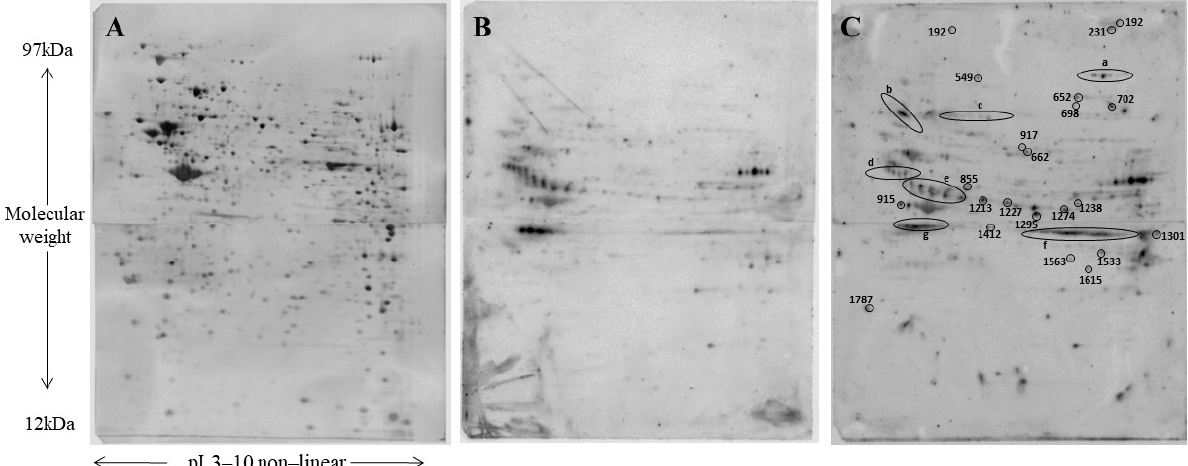
Figure 1. 2-DE coupled with WB was employed to detect specific phosphorylated proteins. Proteins from C2C12 cells were firstly separated according to pI on Immobiline Dry-Strips (18 cm, non-linear gradient pH 3–10) and then according to molecular weight using 11% polyacrylamide gels. Subsequently, proteins were transferred onto nitrocellulose membranes. Immediately after WB, membranes were stained with RuBP. Thereafter, membranes were incubated with the anti-phosphothreonine antibody. ( A ) A representative nitrocellulose image with a 2-DE protein map of C2C12 cells (control). Proteins were detected by RuBP staining. ( B ) The same membrane with detection of the immunoreactive spots. ( C ) A representative nitrocellulose membrane with detection of the immunoreactive spots of C2C12 cells treated with FA5. Spots differentially phosphorylated are highlighted.